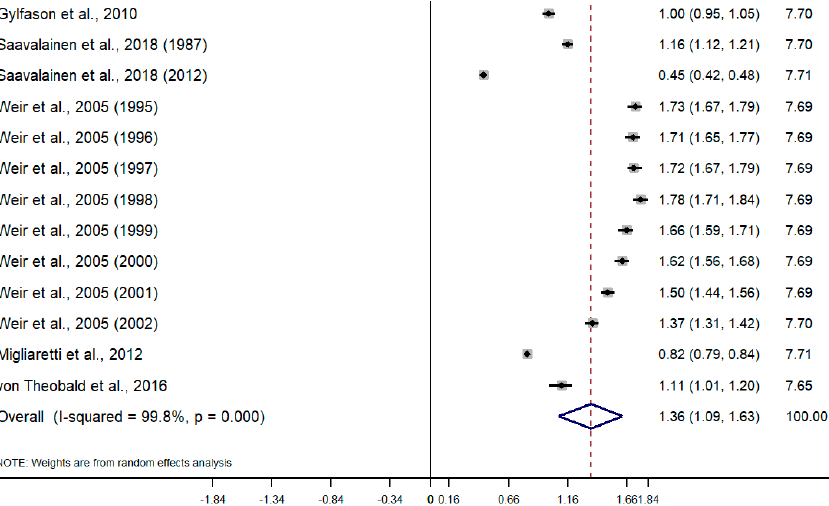
Figure 5. Meta-analysis of the incidence of endometriosis per 1000 person-years based on hospital discharge databases. Note: black lines with squared dots—the prevalence with confidence intervals for each individual study; rhombus—pooled prevalence with confidence interval; red dotted line— line of no effect (studies crossing the line are not statistically different).